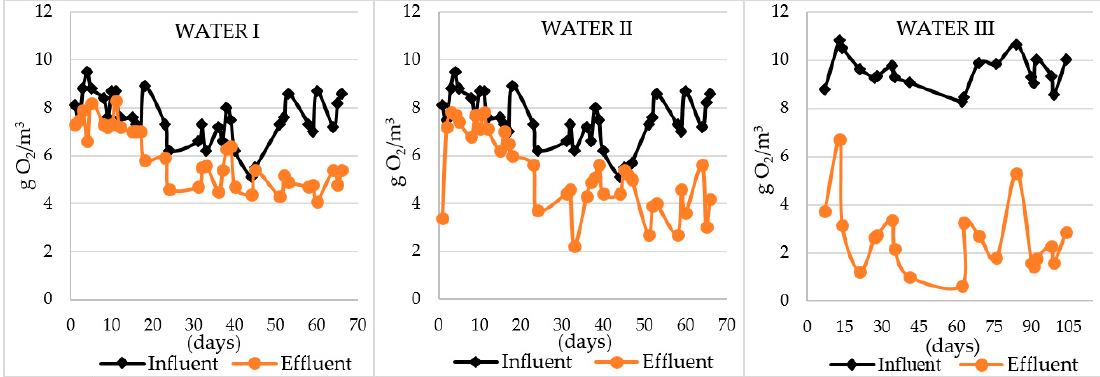
Figure 7. Change in the content of dissolved oxygen after biofiltration on the chalcedonite bed in the analyzed systems.